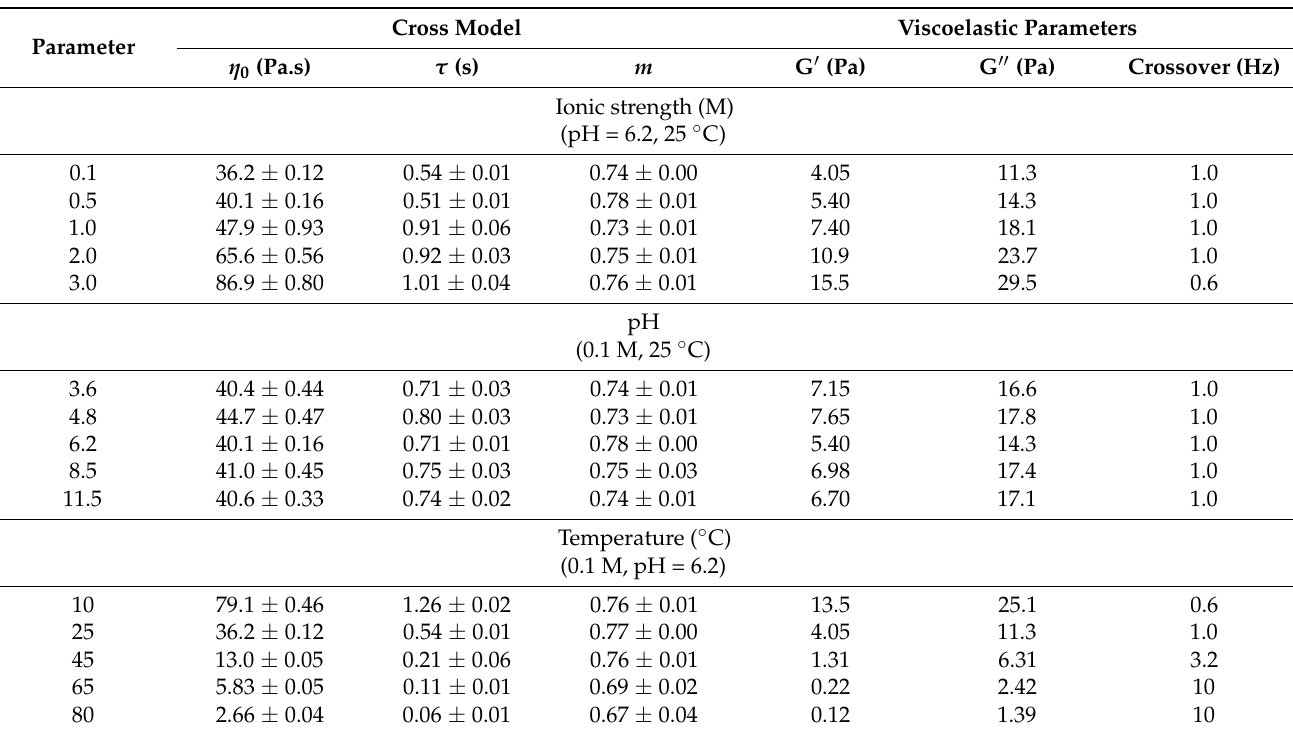
Table 3. Cross model parameters estimated for d-FucoPol aqueous solutions (3.0 wt%) tested at different ionic strength, pH, and temperatures. η 0 —apparent viscosity of the first Newtonian plateau; τ —relaxation time; and m —dimensionless constant. Data are shown as the average ± standard deviation (SD) (n = 3). Viscoelastic parameters estimated for d-FucoPol (3.0 wt%). G (cid:48) —storage/elastic modulus and G (cid:48)(cid:48) —loss/viscous modulus at f = 0.1